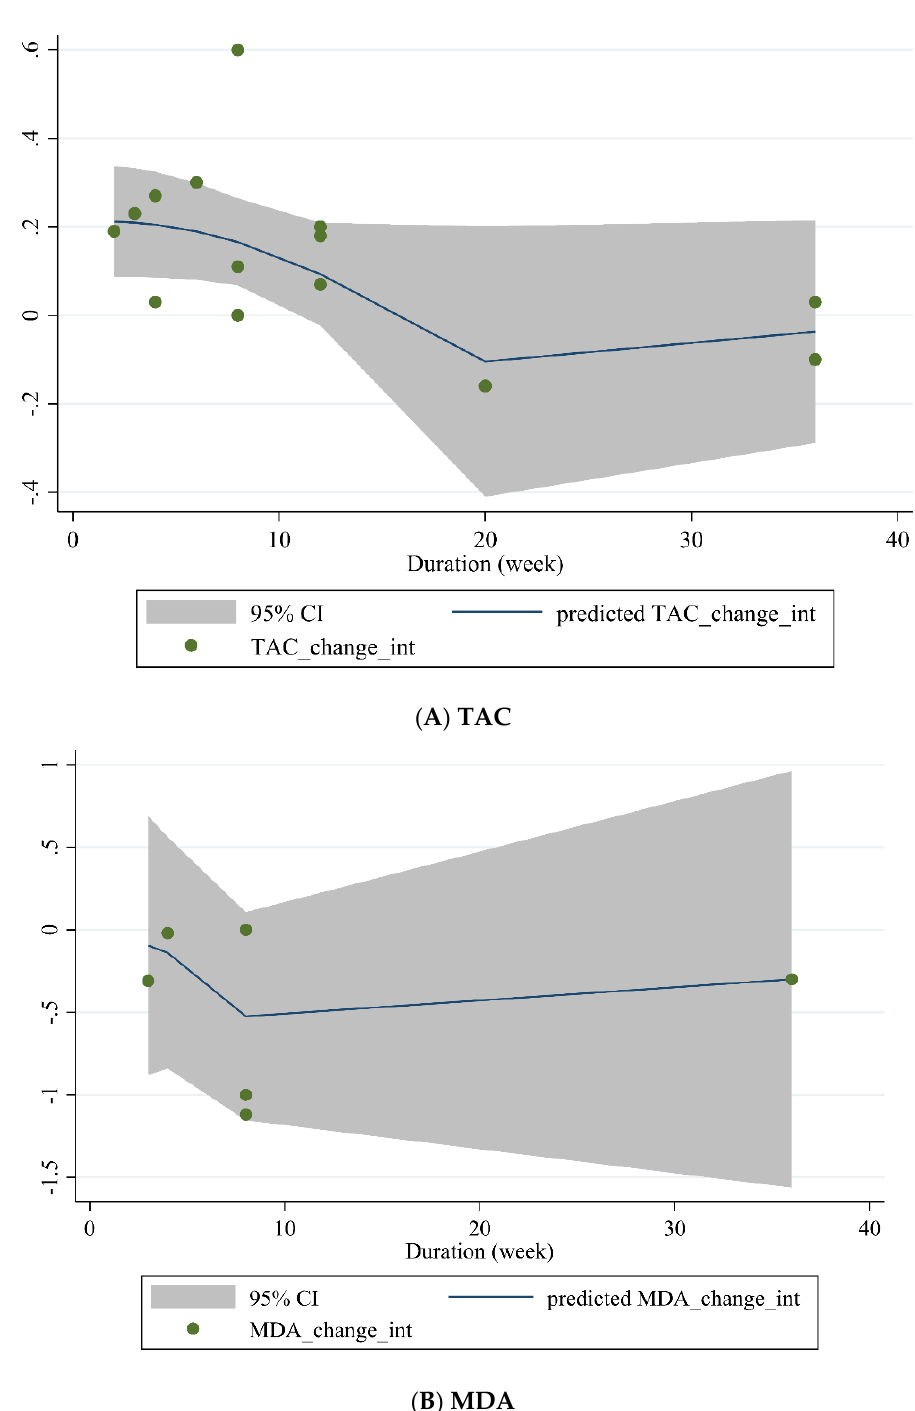
Figure 5. Non-linear dose-response relations between duration of intervention (weeks) and pre- dicted changes in ( A ) TAC and ( B )